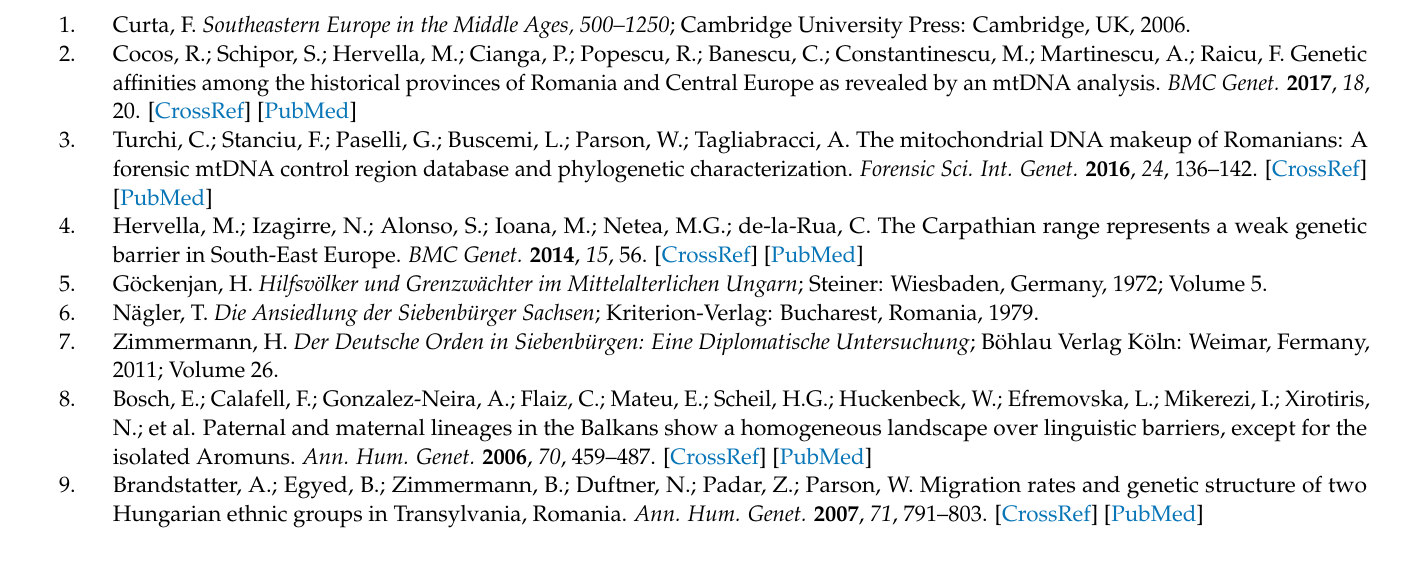
Table S3: MtDNA profile of the investigated samples, Table S4: MtDNA haplogroup frequencies used for PCA with 21 historical populations, Table S5: Fst values, p -values and Slatkin Fst matrix of the 21 historical populations, Table S6: Fst values, p -values and Slatkin Fst matrix of the medieval population from Feldioara and modern Eurasian